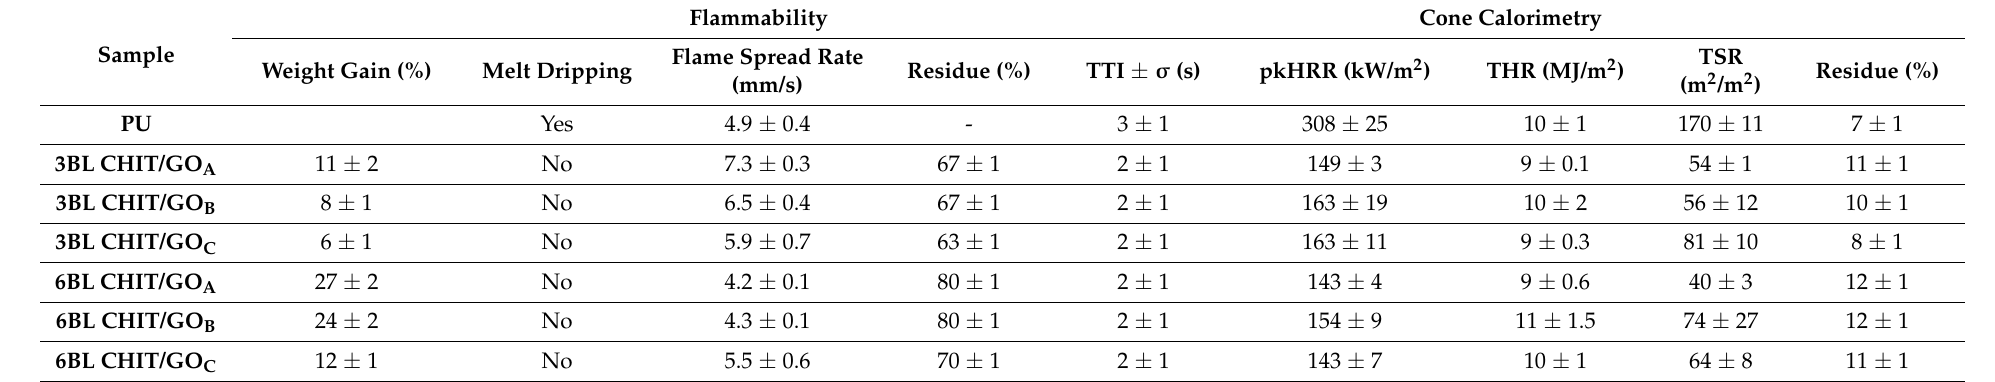
Table 2. Weight gain, flammability and cone calorimetry results for neat and LbL-treated PU